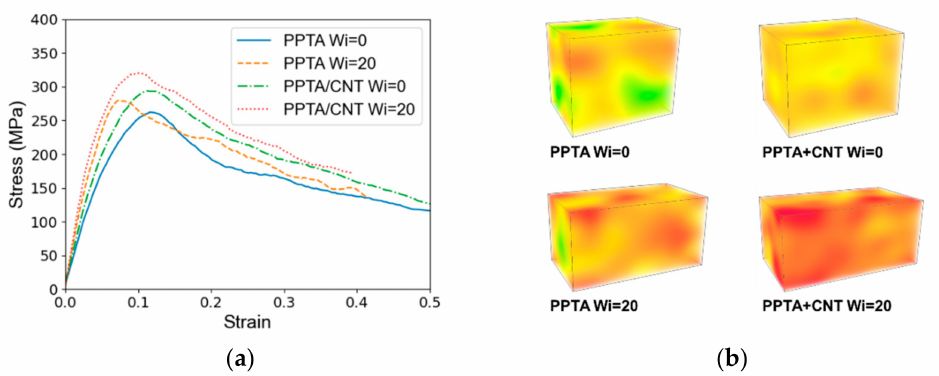
Figure 5. Correlation functions calculated from SAXS. ( a ) When the Wi is 0, the nanostructure of the PPTA system with CNTs is similar to that of the system without CNTs. ( b ) When the shear Wi is 20, the PPTA system with CNTs forms layered microfibers, and the correlation function of the solidification process is significantly different from that of the system without CNTs.